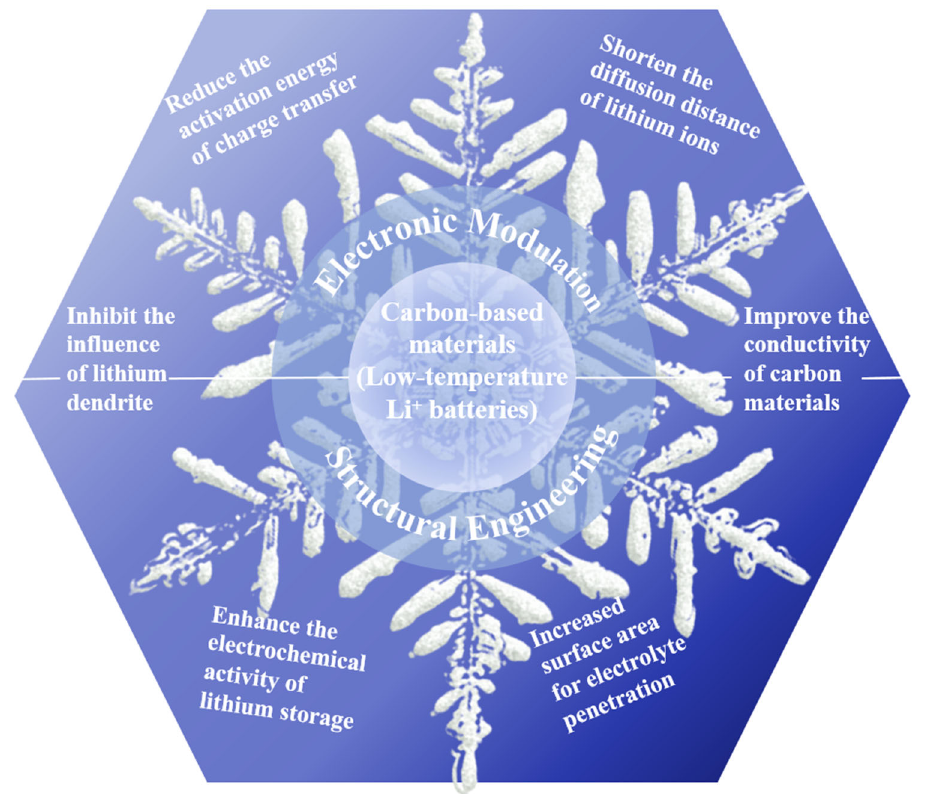
Figure 1. A schematic illustration of key obstacles and strategies of carbon ‐ based materials for low ‐ temperature LIBs.